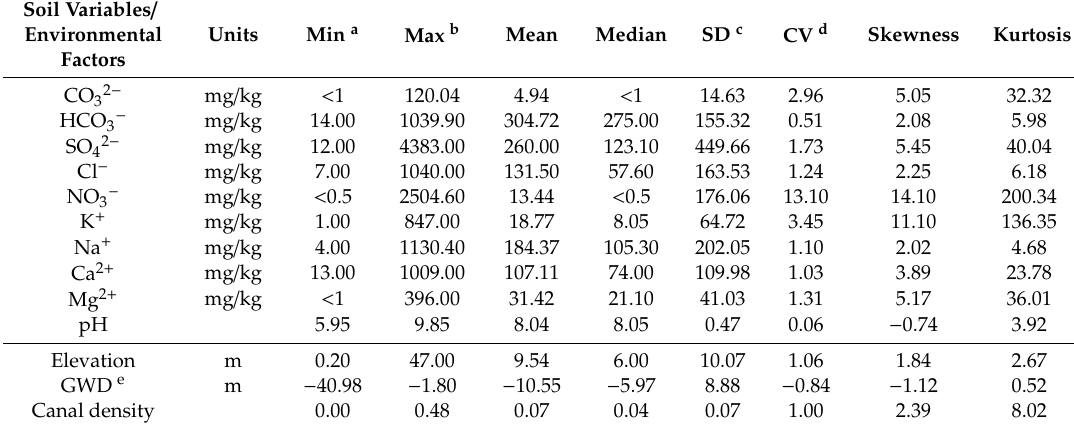
Table 1. Descriptive statistics of chemical composition of soil samples ( n = 204) from the Chaobai River (CBR) basin. Those of environmental factors are also